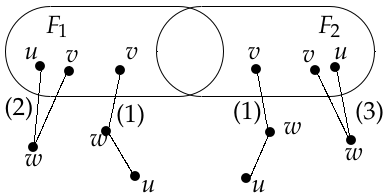
Figure 3. Illustration of a distinguishable pair ( F 1 , F 2 ) under the MM*